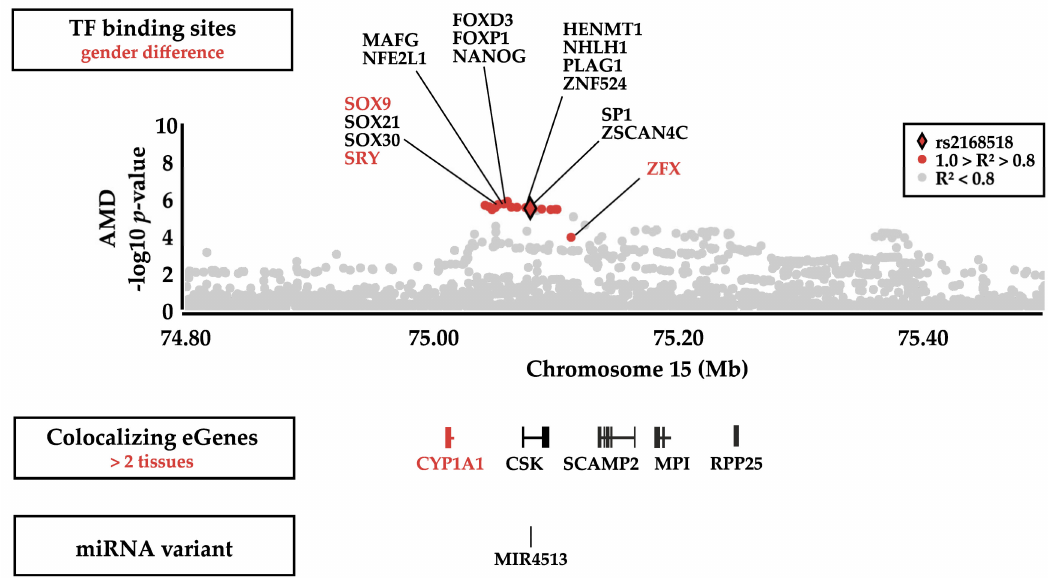
Figure 5. Locus scheme of functional mechanisms within the AMD association signal. The Manhattan plot represents the association p -values with late-stage AMD. rs2168518 is highlighted as a red diamond and all variants strongly linked with rs2168518 (R 2 > 0.8 in Europeans) are displayed as red dots. Potentially altered transcription factor (TF) binding sites are shown with regard to the approximate chromosomal position. TFs related to gender di ff erences, due to their location on sex chromosomes (SRY and ZFX) or because they are direct target genes of TFs located on sex chromosomes (SOX9), are highlighted in red. Below the Manhattan Plot are schemes of eGenes colocalizing with the AMD association signal and eGenes are displayed in regard to their approximate chromosomal position. eGenes colocalizing with the AMD association signal in more than two tissues are highlighted in red. As rs2168518 is located within hsa-mir-4513, the chromosomal position of this microRNA (miRNA) is shown below the colocalizing eGenes with AMD. The raw version of the Manhattan Plot was created with Locuszoom